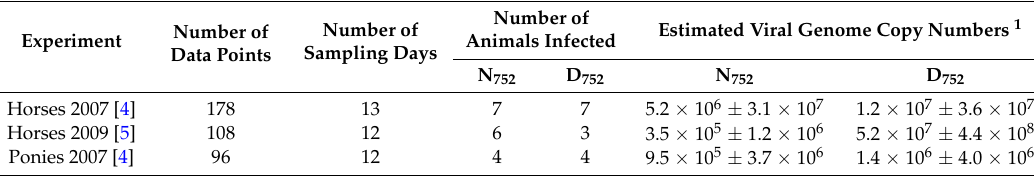
Table 1. Overview of analyzed data.